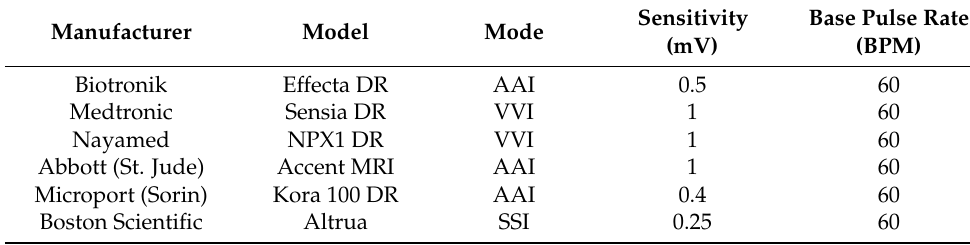
Table 1. List of tested PMs with the specific models and programmed